Question: Describe this figure in one sentence.
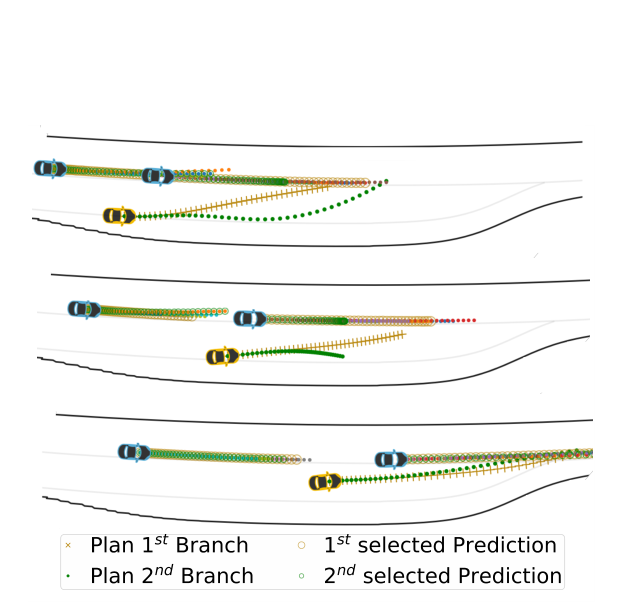
Answer: AV behavior at three different timesteps. Initially, the AV does not commit to merging in front or behind the first TP. As uncertainty reduces, the branches converge.